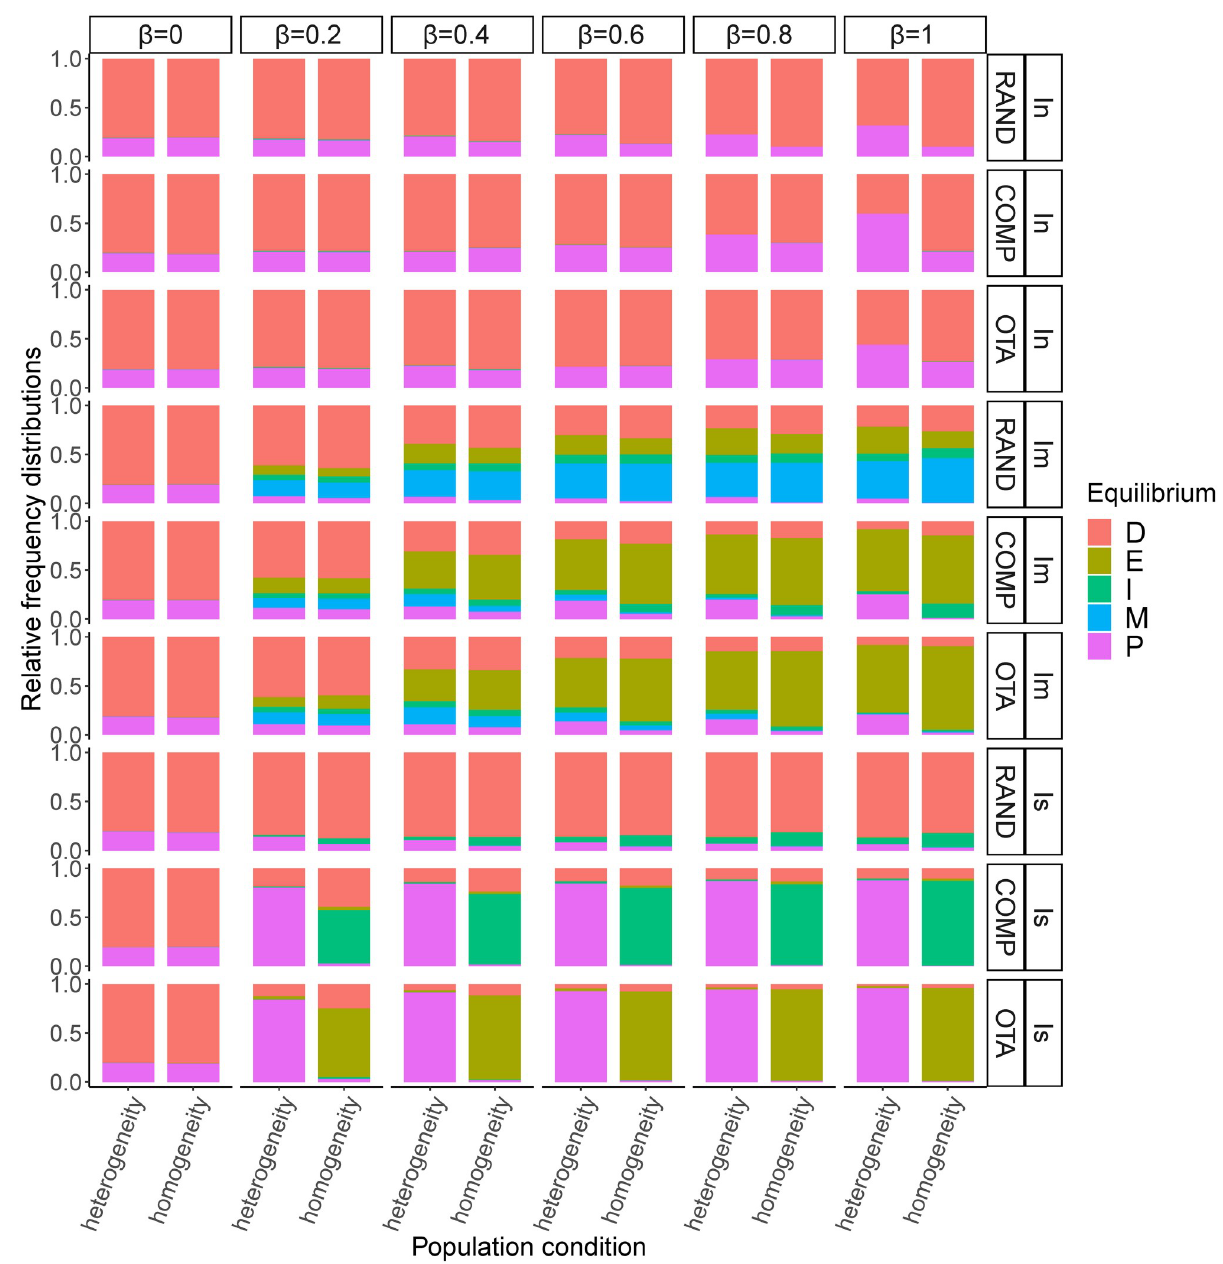
Fig 7. Relative frequencies of each equilibrium category when the frequency of opinions stabilises in the model under value-aggregating institutions. Institution influence: I = neutral; I = moderate and I = strong; β = opinion value bias; value system types: OTA = one takes all, COMP = n m s competition between two opinions, RAND = random. When institutional influence is intermediate, moderate consensus is more likely when the initial dispersion of values is high RAND , and extreme consensus is more likely under OTA and COMP . When institutional influence is strong, the probability of polarisation increases. In general, in the absence of institutional influence there is a high diversity of opinions at equilibrium.